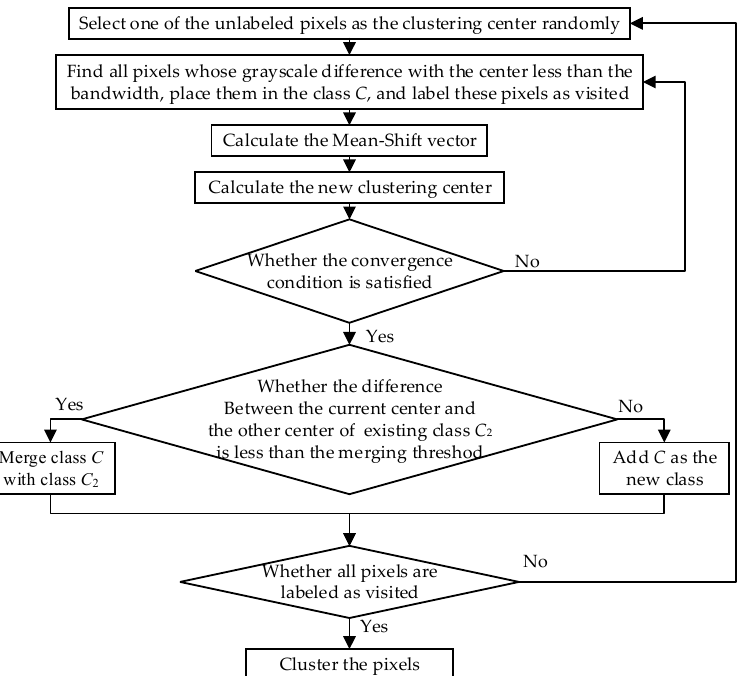
Figure 9. Clustering process of Mean-Shift algorithm.